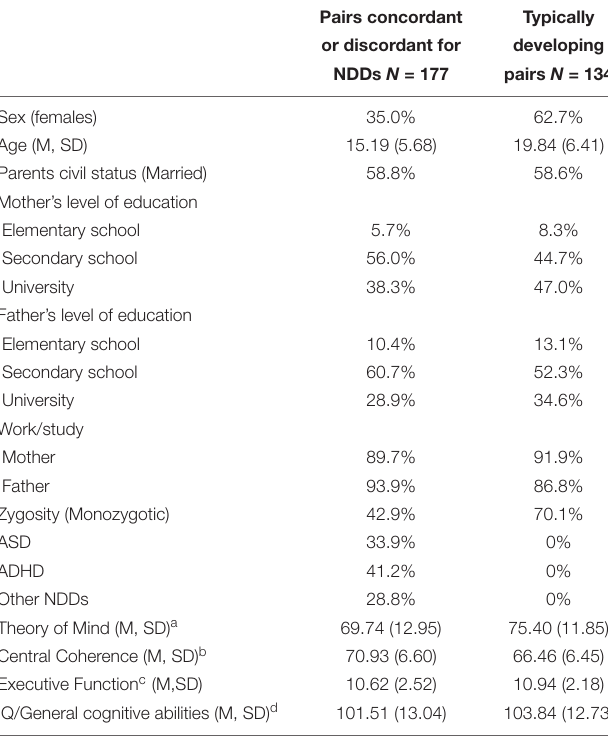
TABLE 1 | Sample characteristics and included